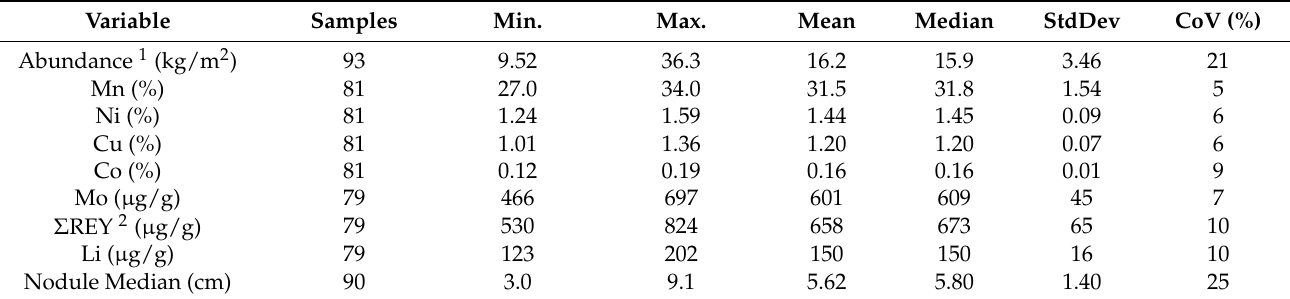
Table 5. Statistics of box core data from PA1-West.